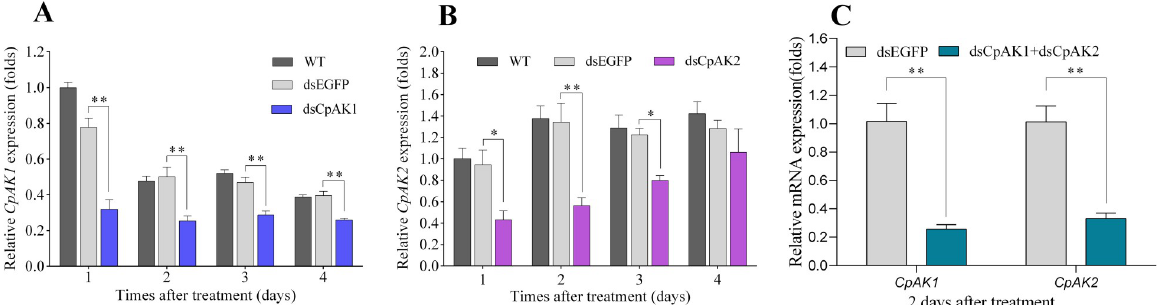
Fig 5. Relative expression levels of CpAK1 and CpAK2 after injection of dsCpAK1(A), dsCpAK2(B) and dsCpAK1+dsCpAK2(C) in Cx . pipiens pallens . All data were expressed as the mean ± Standard Error (SE). Significant difference was analyzed by one-way ANOVA test ( � P < 0.05, �� P < 0.01).